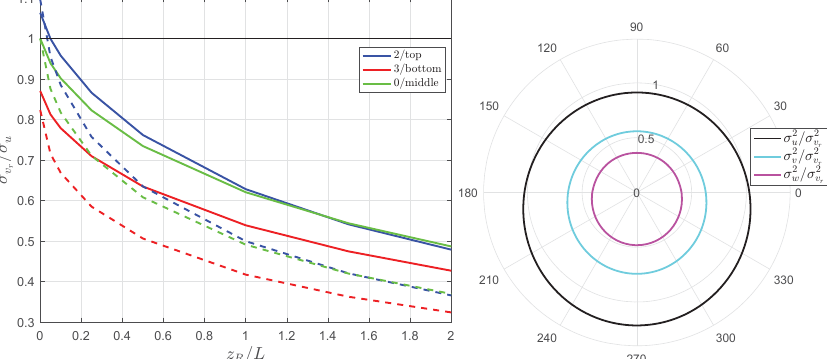
Figure 4. (Left) Variance of the lidar beams’ radial velocity (divided by the u component variance) of the 2/top, 3/bottom and 0/middle beams of the pulsed/CW (solid/dashed lines) lidars as a function of z R /L . (Right) Ratio of the variance of each of the velocity components to that of lidar beam as function of azimuthal position for z R /L = 0. Turbulence characteristics are computed for ϕ = 15 ◦ and Γ=3